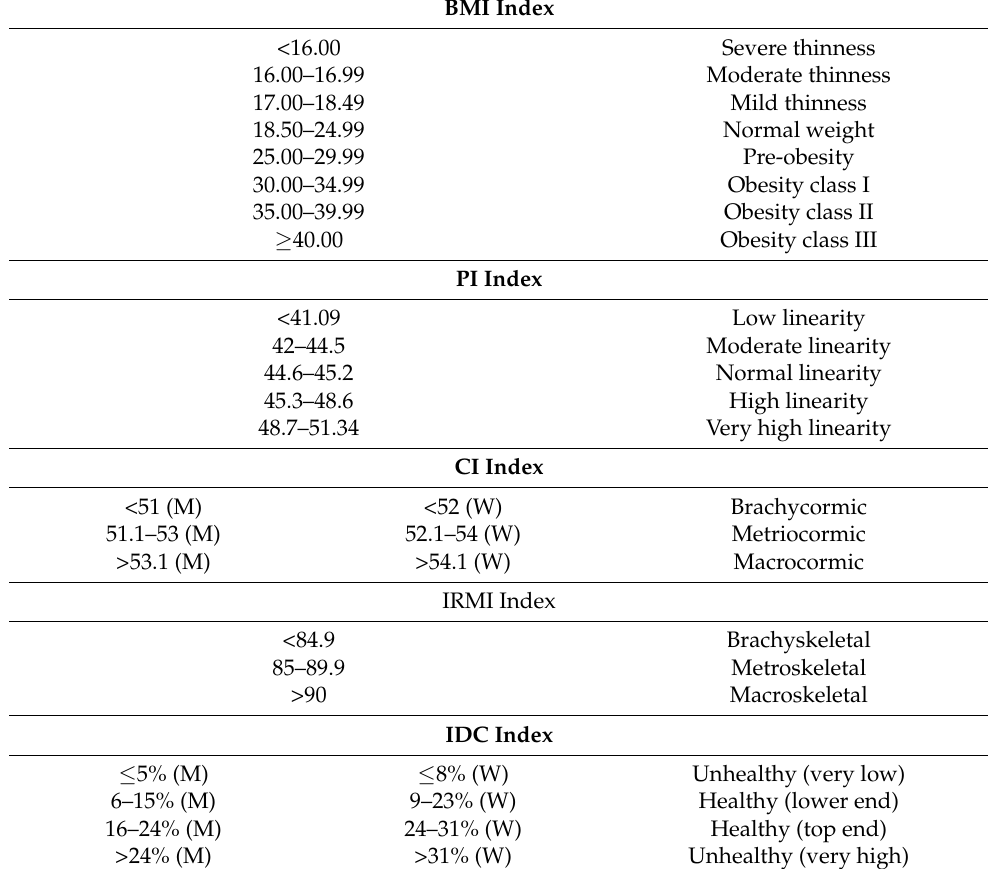
Table 1. Categorical division of the different indices based on the quantitative value obtained. BMI = Body Mass Index, PI = Weight Index, CI = Cormic Index, IRMI = Relative Lower Limb Index, IDC = Body Density Index. (M) = Men, (W) =